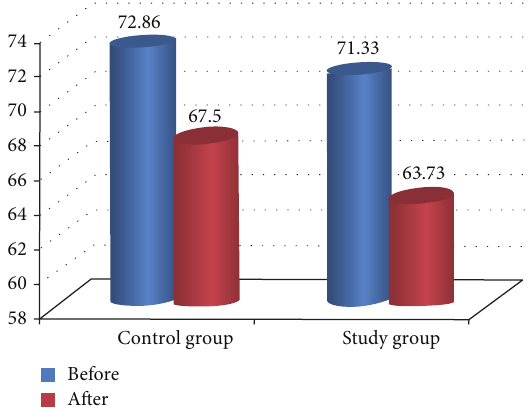
Figure 6: Comparison between pre- and posttreatment in stance phase % for both